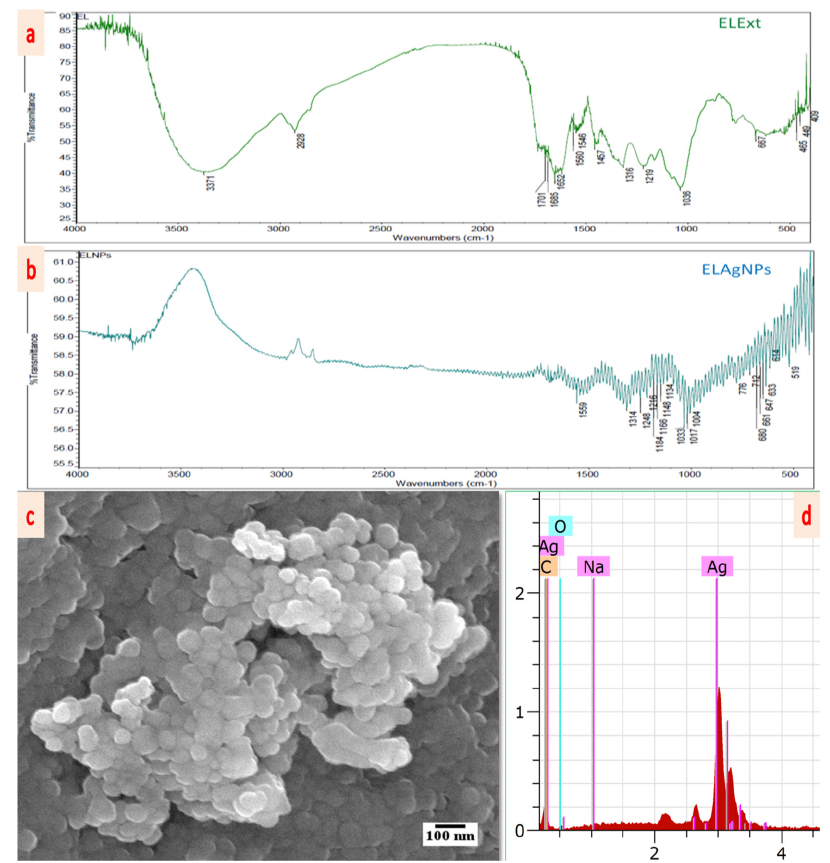
Figure 3. FTIR spectrum of ( a ) ELExt and ( b ) ELAgNPs. ( c ) FESEM micrographs of ELAgNPs. ( d ) EDX spectrum of ELAgNPs.